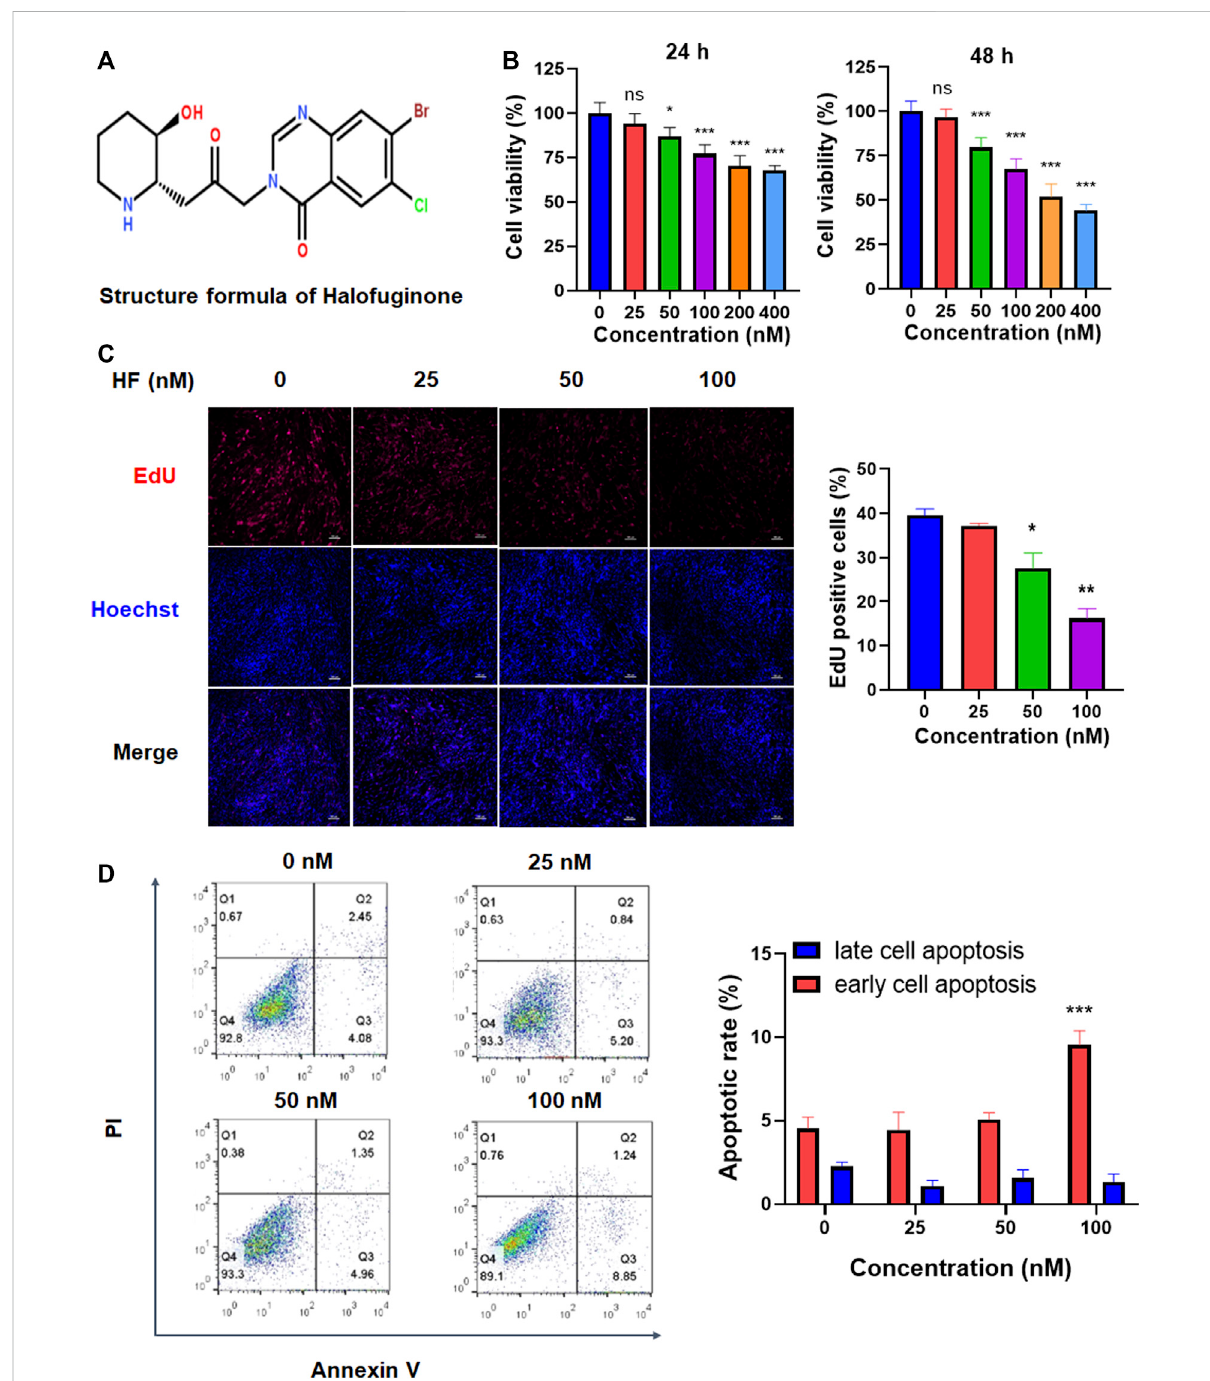
FIGURE 2 TheeffectsofHalofuginoneonCAFviability,proliferationandapoptosis. (A) ChemicalstructureofHF. (B) CAFsweretreatedwithorwithoutHF (25,50,100,200,400 nM)for24hor48 h,andcellviabilityofCAFswasdetectedbyCCK8; (C) CAFsweretreatedwithorwithoutHF(25,50,100 nM) for 48 h, cell proliferation was detected by EdU staining. (D) Cell apoptosis was analyzed by fl ow cytometry. *: p < 0.05, **: p <